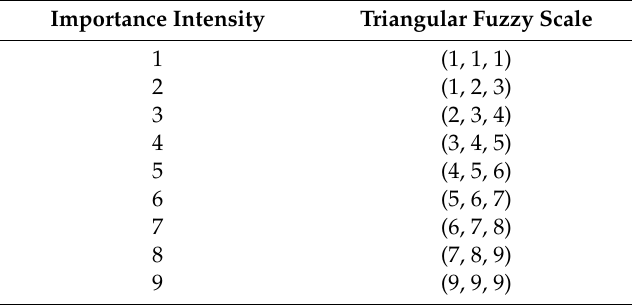
Table 3. The fuzzy conversion scale.